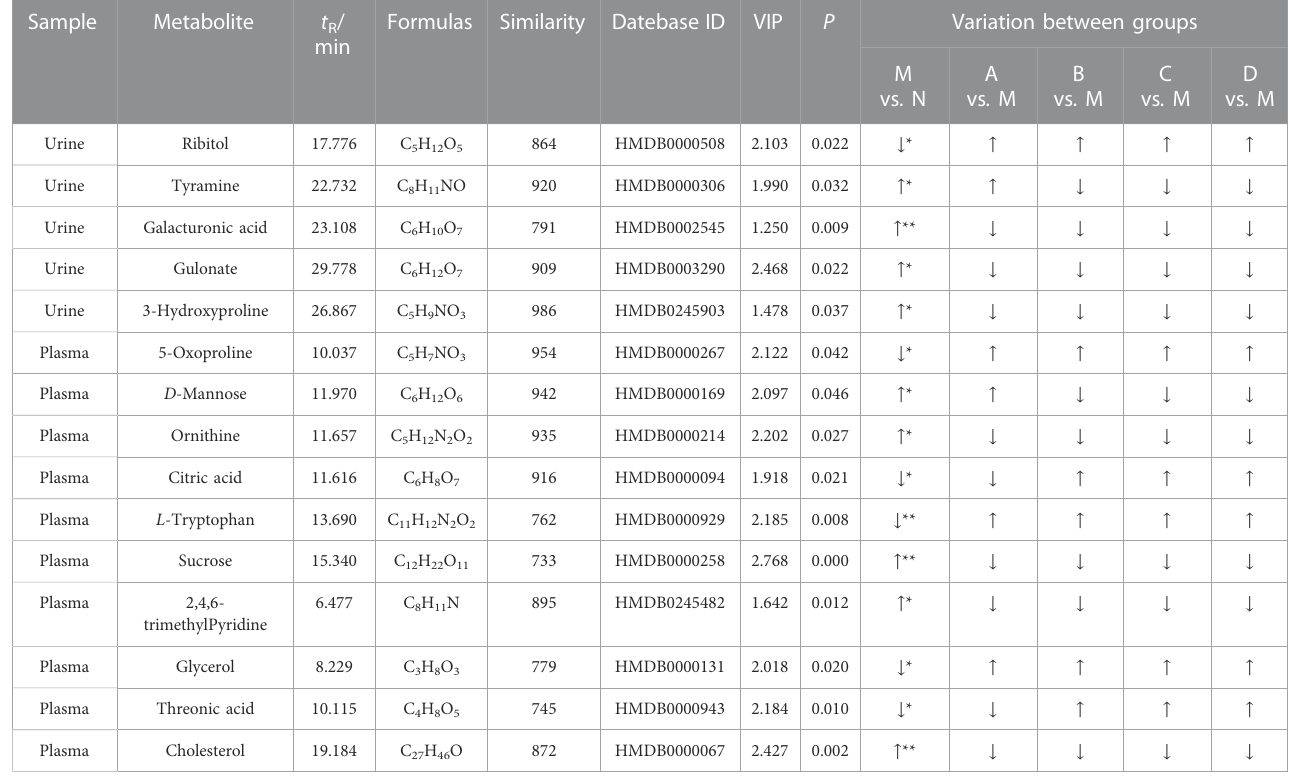
TABLE 1 Biomarkers of urine and plasma in kidney-yang de fi ciency rats (n = 6, Mean ± SD). Sample Metabolite t R / Formulas min